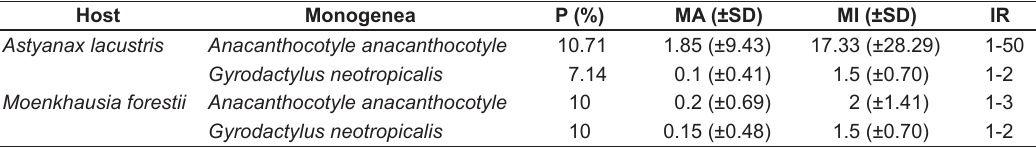
Table 1. Gyrodactylidae parasites of Astyanax lacustris and Moenkhausia forestii , from the upper Paraná River